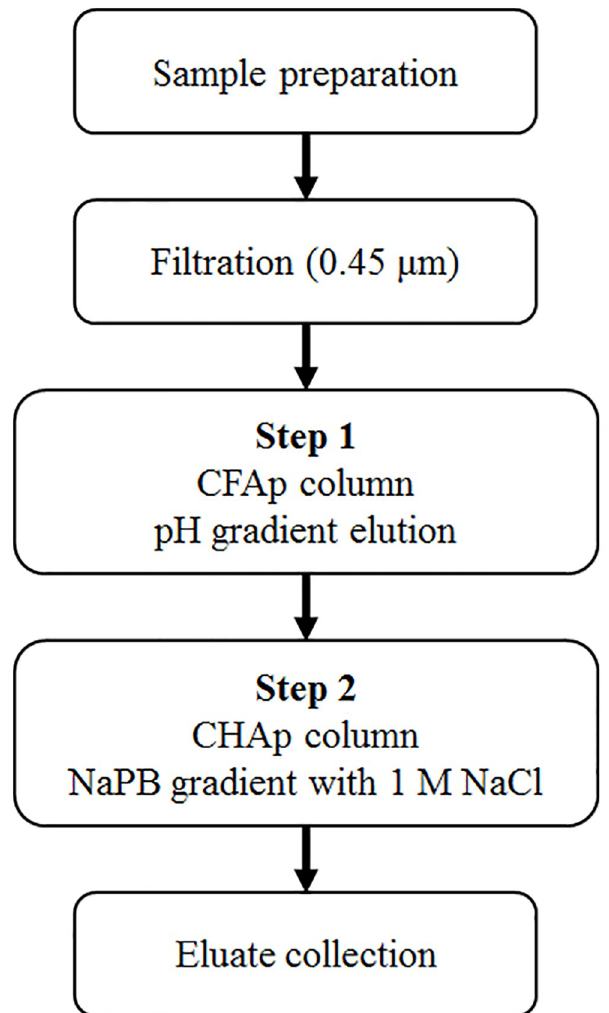
Fig 1. Standardized two-step purification procedure. CFAp, ceramic fluoroapatite; CHAp, ceramic hydroxyapatite; NaPB, sodium phosphate buffer.